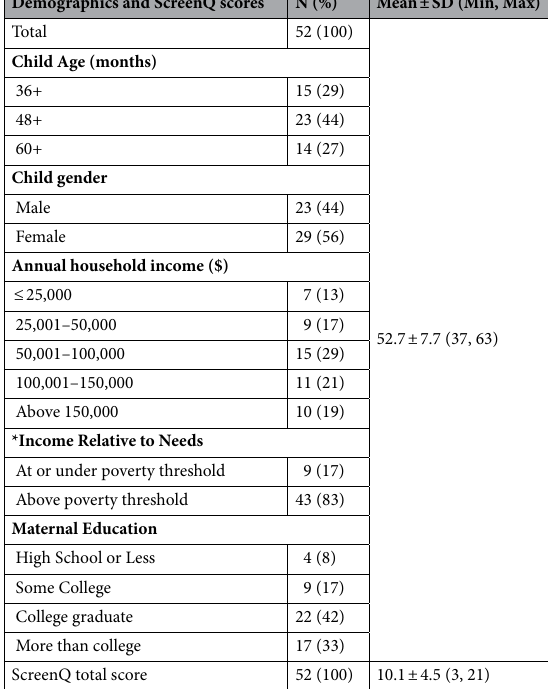
Table 1. Demographics and ScreenQ Scores. *2020 US Department of Health and Human Services Poverty Table (income to household